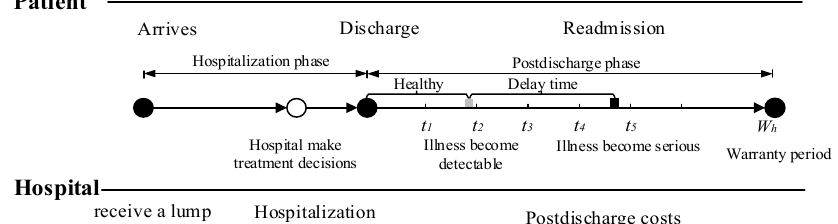
Figure 1. Sequence of